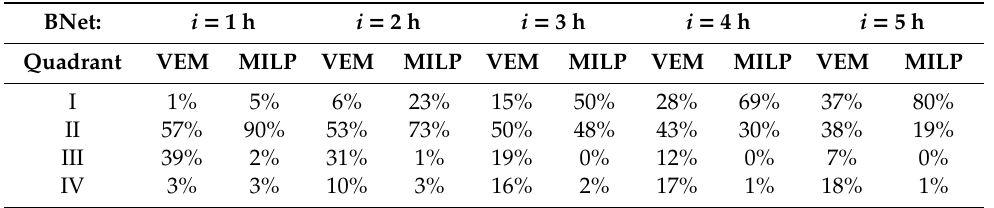
Figure 9. Comparison of the BNet results for each forecast time step ( i = 1 to 5 h) with the Volumetric Evaluation Method (VEM) ( a ) and mixed integer linear programming (MILP) ( b ) for 2000 synthetic episodes of flood. Table 5. Percentage of episodes classified by quadrants when comparing ∆ O max and ∆ WL max between the BNet, from i = 1 h to 5 h, and the VEM and MILP methods.